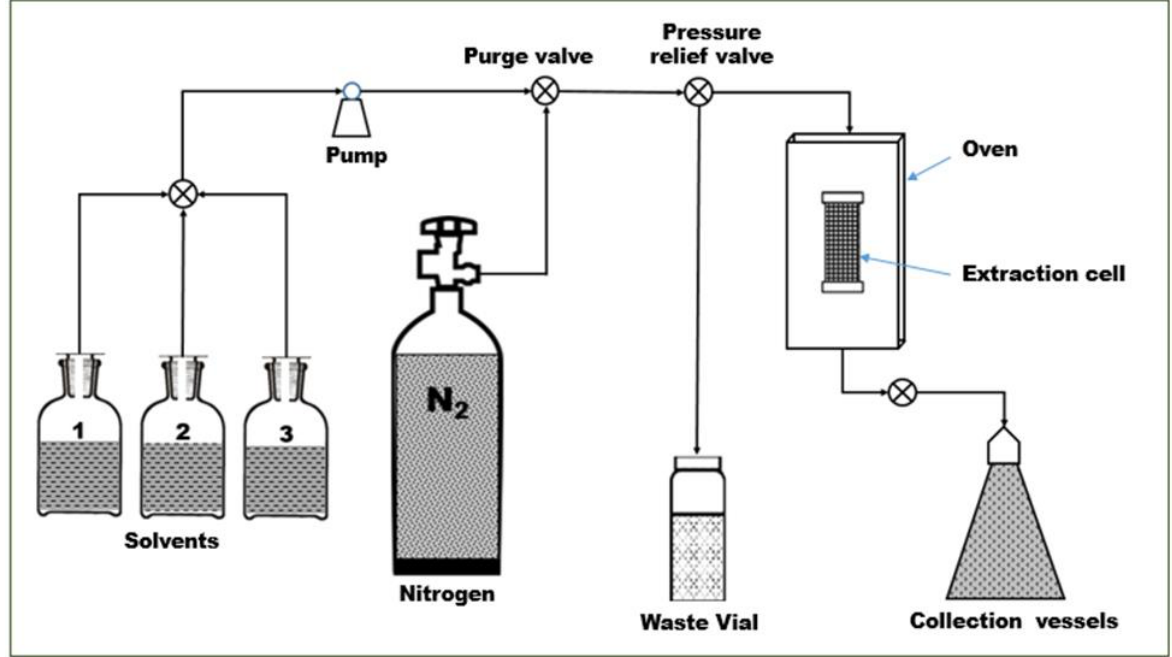
Figure 3. Illustrative diagram of pressurized liquid extraction (PLE).